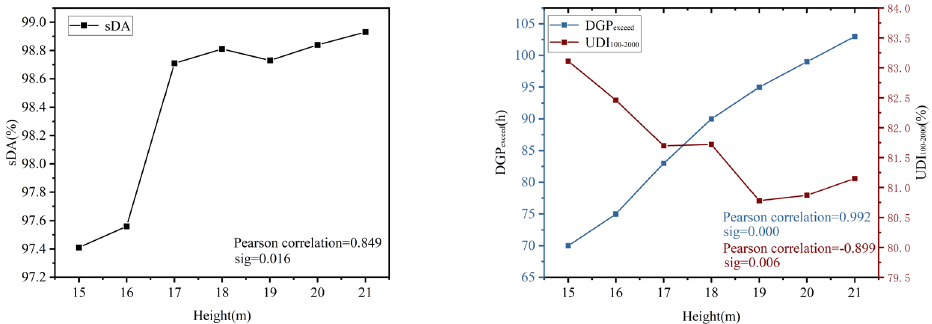
Figure 10. Analysis of building height simulation results.